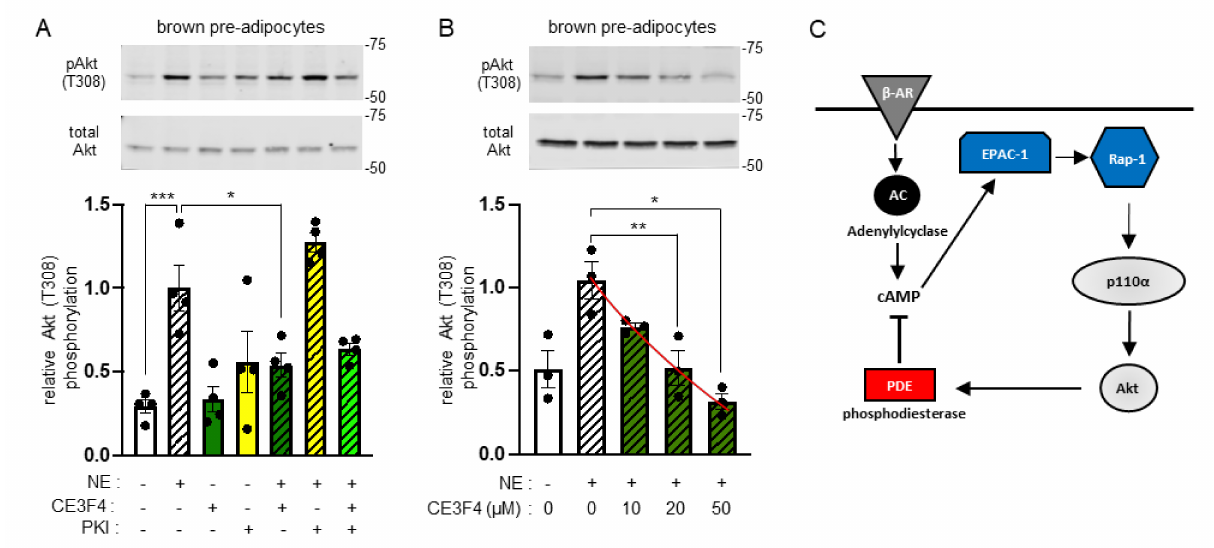
Figure 5. Activation of Akt downstream of β -AR is mediated by EPAC1. ( A ) Brown pre-adipocytes were treated with the EPAC1 inhibitor CE3F4 (20 µ M, dark green graph bars) or the PKA inhibitor fragment (6-22) amide (PKI, 5 µ M, yellow graph bars) or a combination of both inhibitors (bright green graph bar) followed by stimulation with 1 µ M of norepinephrine (NE, striped graph bars) for 15 min at 37 ◦ C. Levels of Akt T308 phosphorylation were determined by immunoblot analysis. Phosphorylation levels were normalised to total Akt levels detected in a second blot performed in parallel using the same lysates. A representative immunoblot and a bar graph with data from four ( n = 4) independent experiments are shown. ( B ) Dose response of NE-stimulated Akt phosphorylation to CE3F4. Data are presented as mean ± SEM. Statistical analysis was performed by one-way ANOVA with Sidak’s multiple comparisons test between pre-determined pairs of treatments ( A ) or by repeated measures one-way ANOVA with Dunnett’s multiple comparisons test ( B ). * p < 0.05; ** p < 0.01; *** p < 0.001. ( C ) Schematic representation of p110 α -dependent and Akt-mediated activation of PDE upon β -AR stimulation. According to the model, PI3K p110 α and Akt are activated in the β -AR/cAMP pathway through EPAC1 and its target Rap1, as part of a feedback loop that downregulates cAMP levels through Akt-mediated PDE